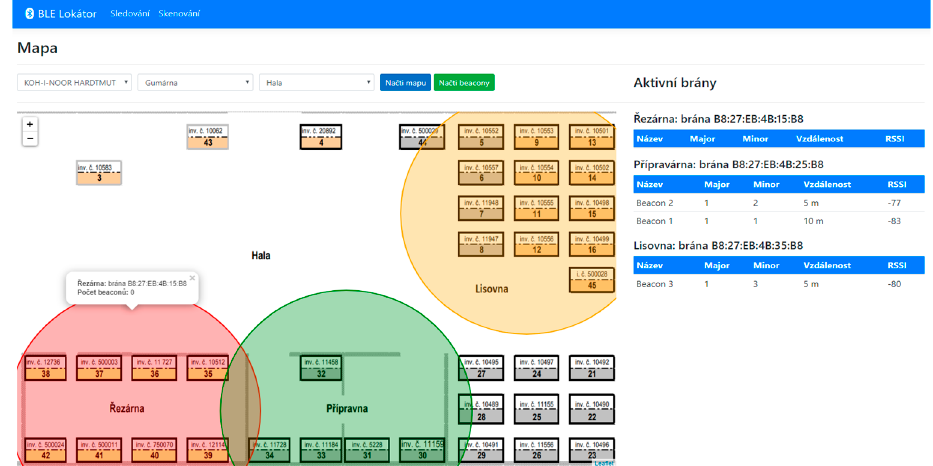
Figure 7. Tracking module testing (screenshot of web interface screen).